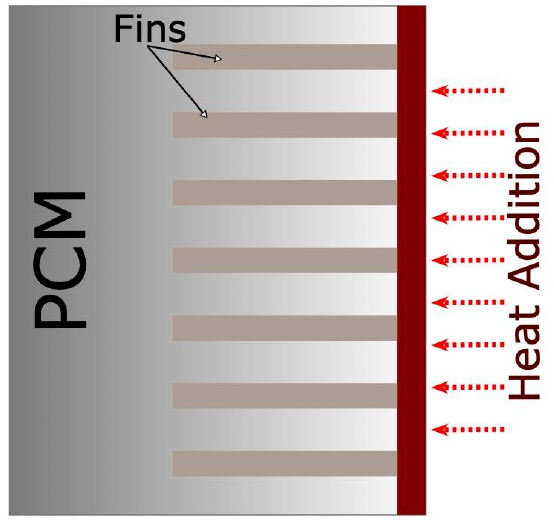
Figure 7. General layout for horizontal fi n or pin use in PCM enhancement studies.